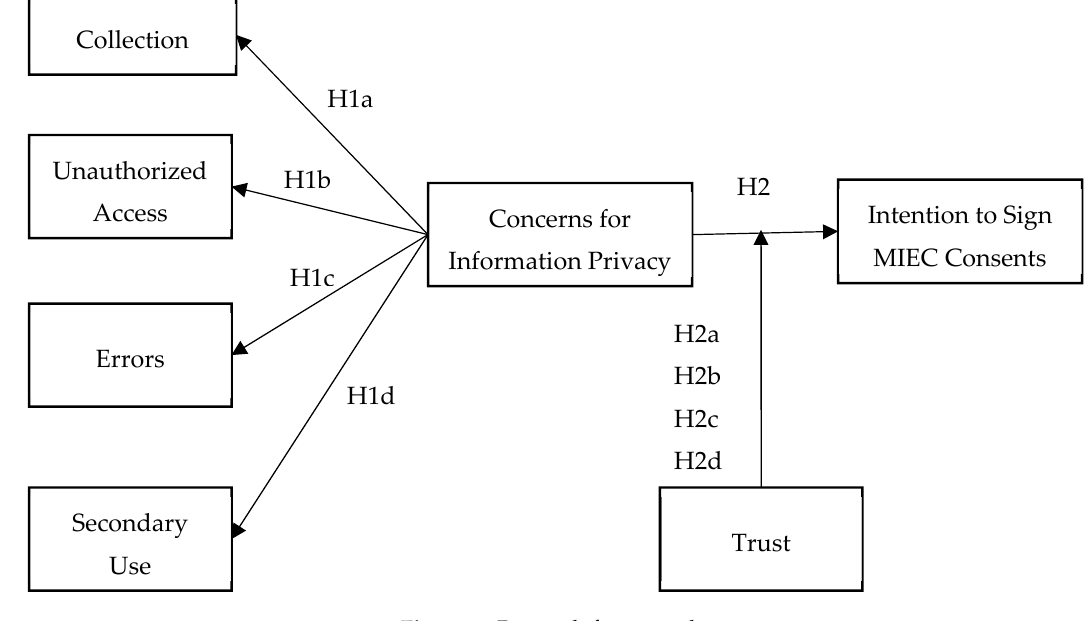
Figure 1. Research framework.